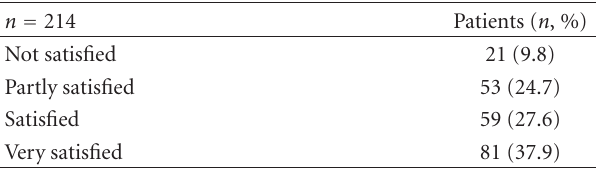
Table 4: Postoperative